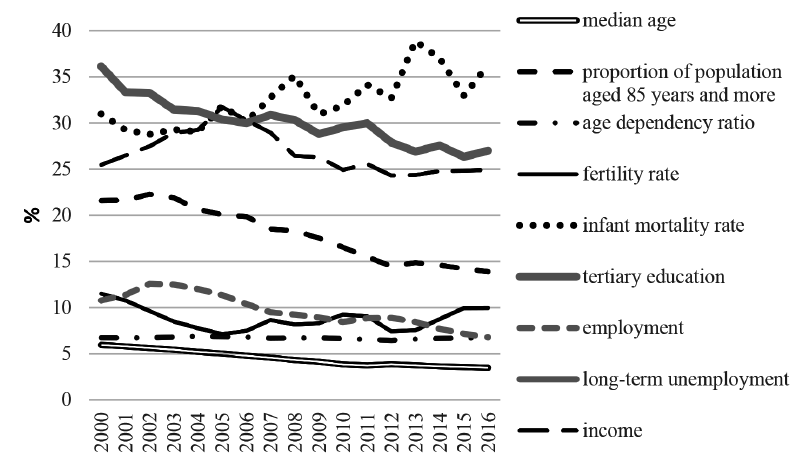
Figure 6. Development of the coefficient of variation in the indicators under examination